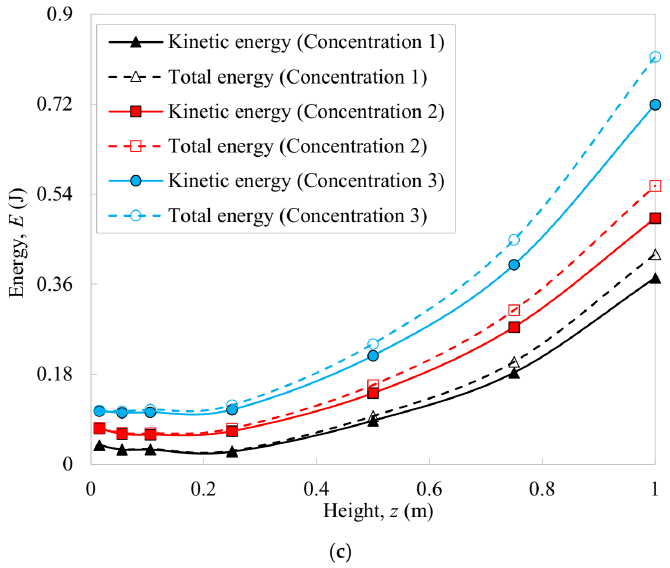
Figure 11. Energy distributions: ( a ) At the test wind speed of 10 m/s; ( b ) At the test wind speed of 13 m/s; ( c ) At the test wind speed of 16 m/s.